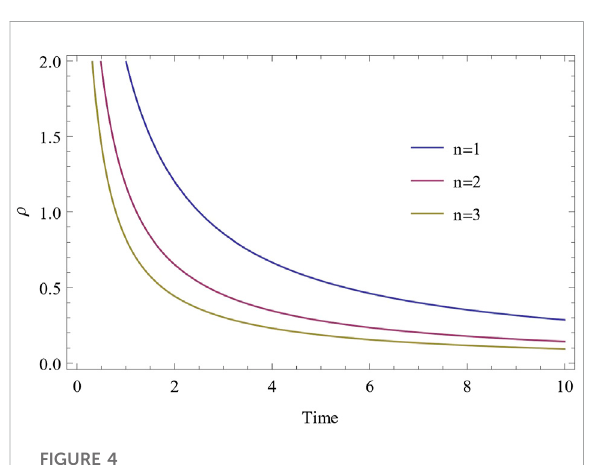
FIGURE 4 The plot of energy density ρ versus time t.